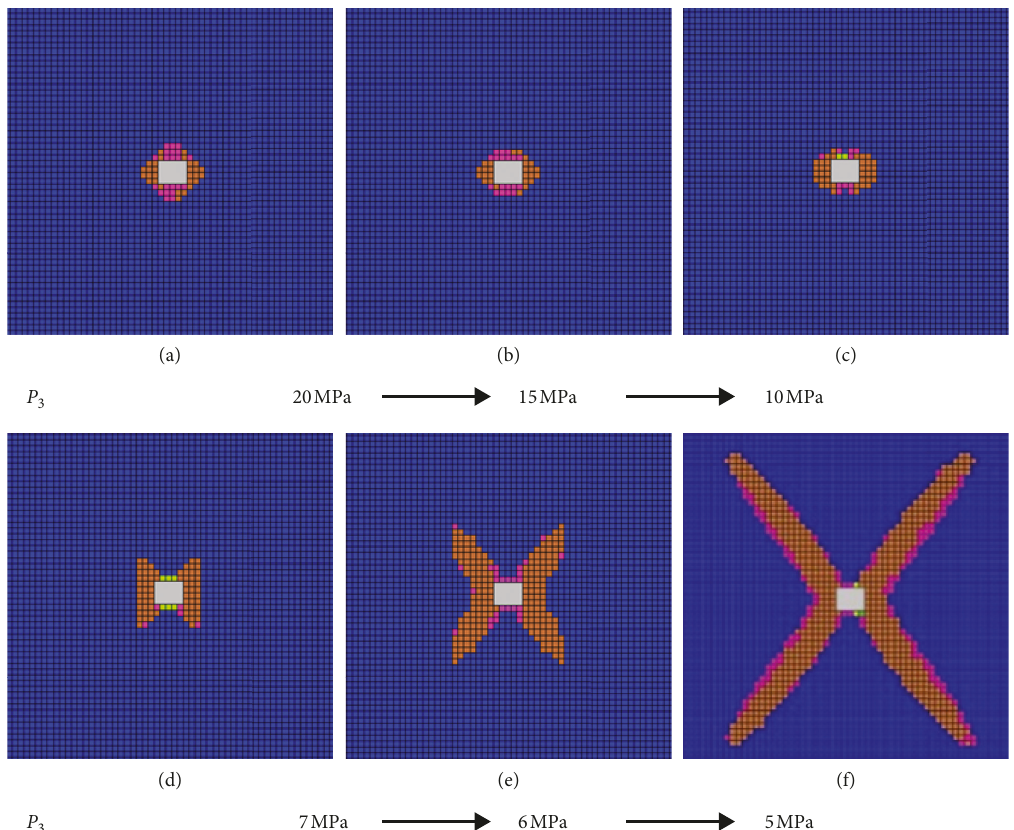
Figure 5: Evolution laws of plastic zone unloading in the direction of minimum confining pressure. (a) R